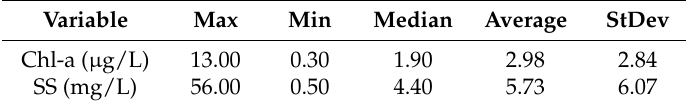
Table 1. Descriptive statistics of the in situ